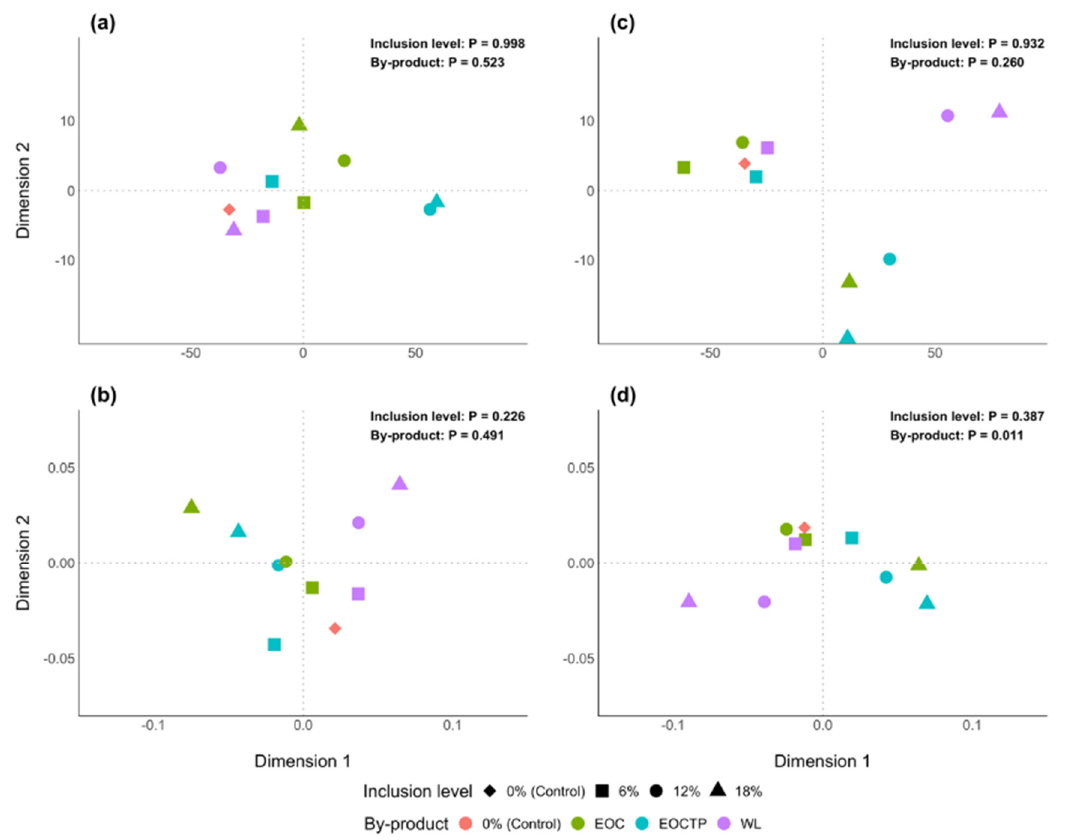
Figure 1. Multidimensional scaling comparison of experimental diets (each point represents an experimental diet). The axes values are arbitrary as in the orientation of the plot. Similarities (more similar diets are closer) among diets of ruminal fermentation parameters (total VFA and CH 4 production, NH 3 concentration and AFOM) and VFA profile (proportions of acetate, propionate, butyrate and branched-chain VFA) at 8 h (( a , b ), respectively) and 24 h of in vitro incubation (( c , d ), respectively). The p values of the MANOVA are also shown.